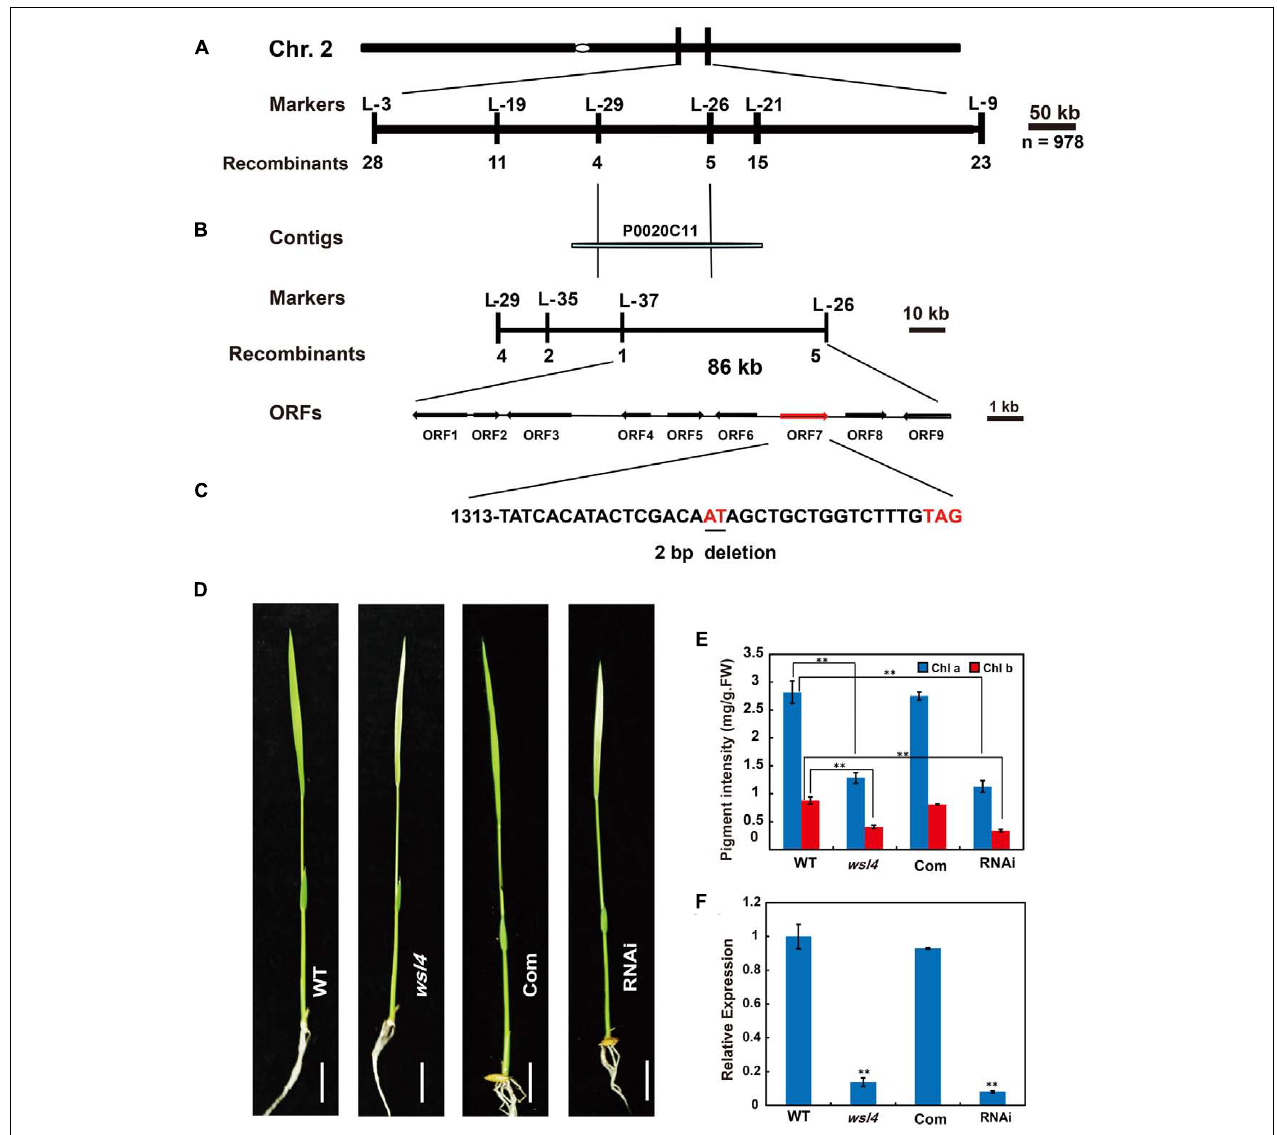
FIGURE 3 | Map-based cloning of the WSL4 gene. (A) The WSL4 locus was initially mapped on the long arm of chromosome 2 between the insertion/deletion markers L-3 and L-9. (B) The WSL4 locus was ultimately narrowed to an 86-kb region between the insertion/deletion markers L-37 and L-26 on BAC clone P0020C11 using 978 F 2 homozygous mutant background plants. Nine open reading frames (ORFs) were predicted in the region. (C) Comparison with WT cDNA sequence revealed a 2 bp deletion ( underlined ) in ORF7, generating a premature stop codon. (D) Phenotypic comparison at the three-leaf stage of WT, wsl4 mutant, complemented T 1 (Com), and RNAi T 1 plants grown in a growth chamber at L30/D25. Bars, 0.5 cm. (E) Chlorophyll contents of L3-3 from plants corresponding to (D) . L3-3 indicates the third leaf at the three-leaf stage. Values are means ± SD from three independent repeats. Student’s t -test: ∗ P < 0.05; ∗∗ P < 0.01. Chl a, chlorophyll a, Chl b, chlorophyll b, FW, fresh weight. (F) Real-time RT-PCR analyses of expression levels of the WSL4 gene in L3-3 of plants corresponding to (D) . The ubiquitin gene was used as an internal control. Data are means ± SD of three repeats. Student’s t -test: ∗ P < 0.05; ∗∗ P <